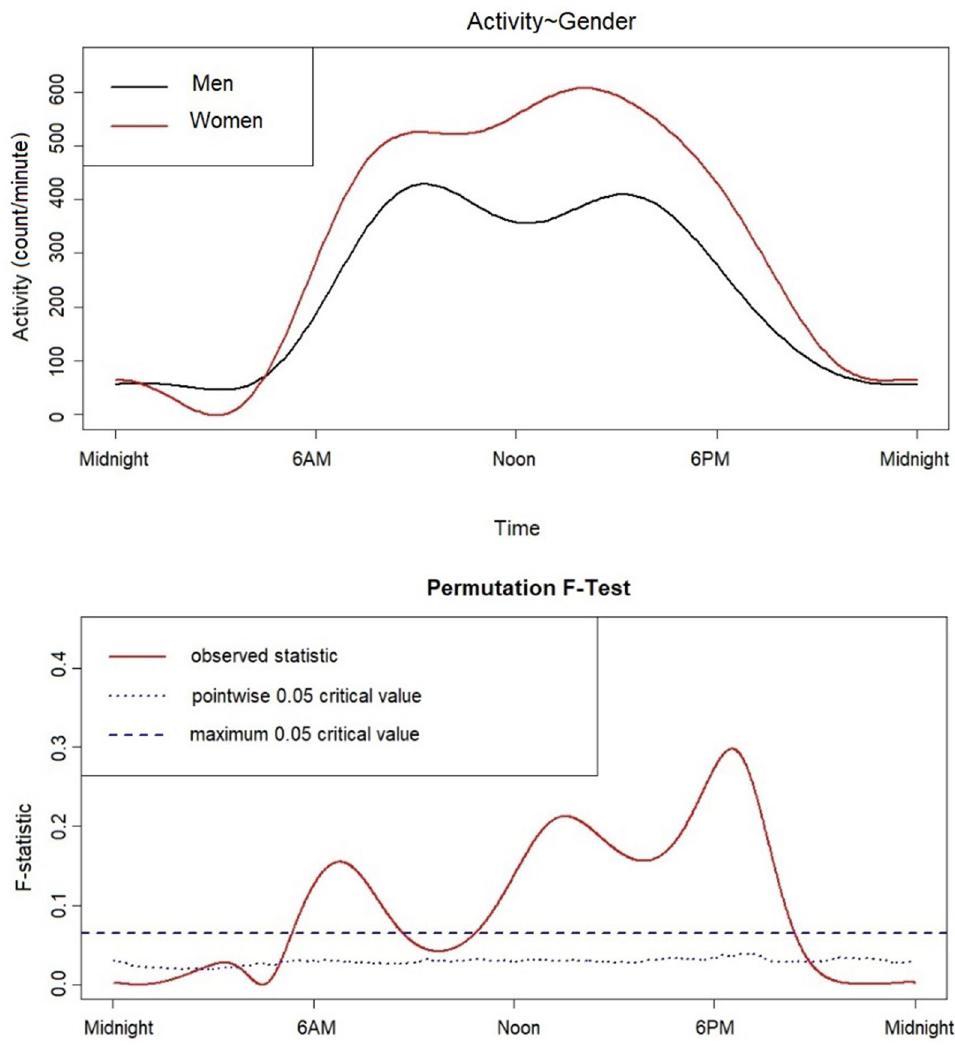
Figure 3. Functional linear modelling comparing 24-h sleep–wake patterns of BaYaka men and women. Women are represented by a red line and men represented by a black line. Women displayed a sharp, steady incline of activity in the morning and generally higher levels of mean activity throughout the day as compared to men, especially in the afternoon. Men show a decline in their activity towards noon, suggestive of resting and/or napping periods before the next peak of activity, and a steady decline throughout the evening. The bottom panel displays a permutation F test; the point-wise critical value (dotted line) displays the proportion of permutation F values at the significance level of 0.05 for every time point. Men and women have significantly different mean circadian activity patterns at the points when the observed F-statistic (represented as a solid line) crosses the critical value (dotted